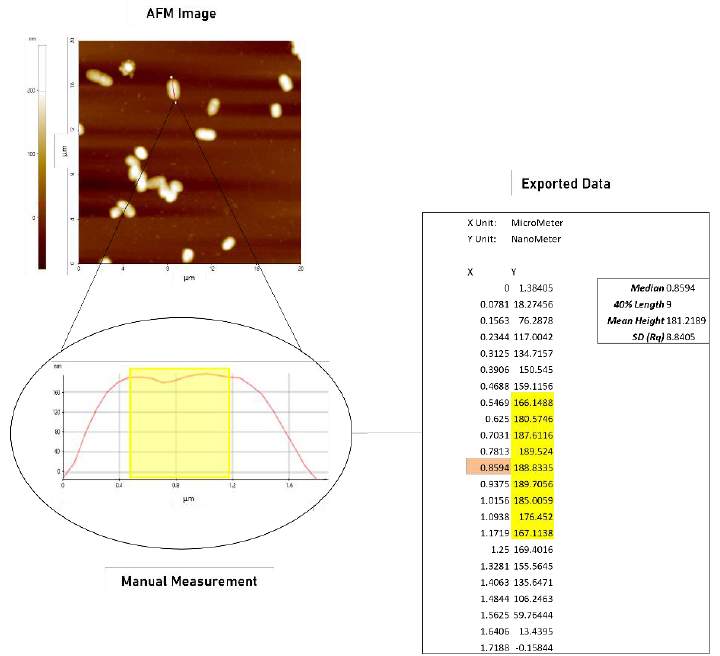
Figure A1. Calculation of surface roughness (Rq) for individual bacteria. After PACF was visualized with AFM, surface roughness values (Rq) were determined manually for individual bacteria. First, height data along a straight longitudinal line through the center of the bacteria were recorded and the data points falling within the central 40% of this line were further considered. The height of the data points of the 40% central line was used to calculate the average and standard deviation. The resulting standard deviation represents the Rq. Taking only the central 40% of the height data assured the Rq value are not influenced by variations of the height slopes at the poles of each bacterium.